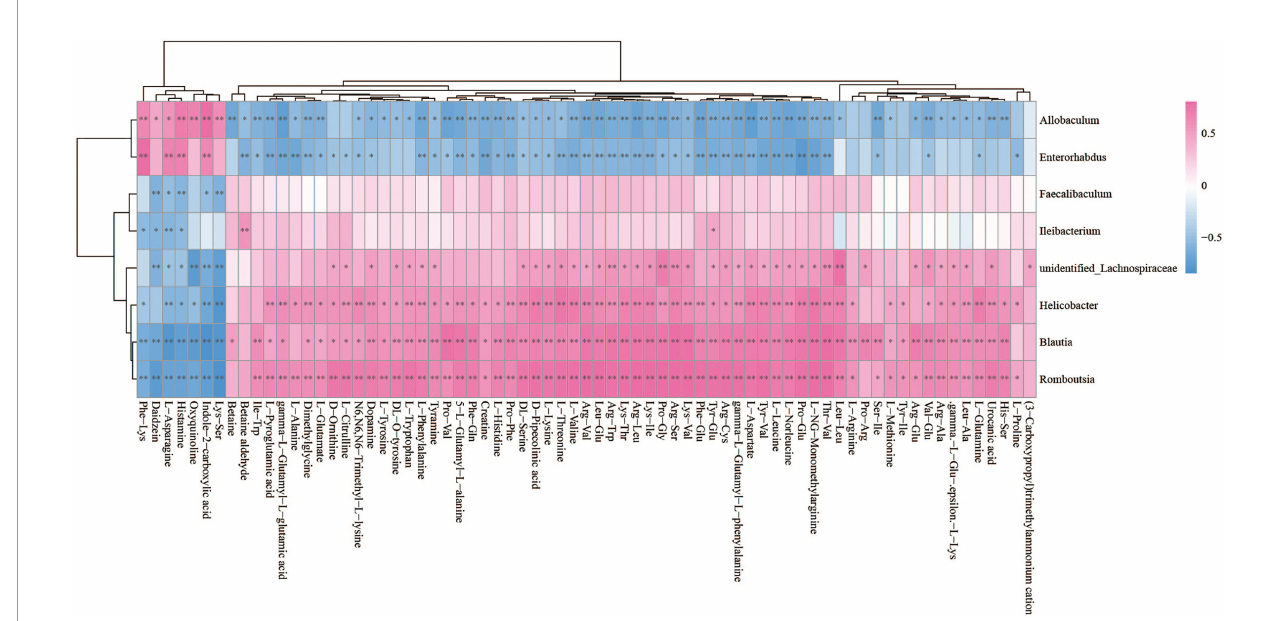
FIGURE 6 | Spearman correlations between signi fi cant bacteria based on LEfSe and differential amino acids and their derivatives are presented in the form of a correlation coef fi cient matrix heat map. The correlation coef fi cient r is shown in color. r >0, positive correlation, shown in red; r < 0 represents a negative correlation, shown in blue, and the darker the color, the stronger the correlation. “ * ” indicated p-value < 0.05, “ ** ” indicated p-value <